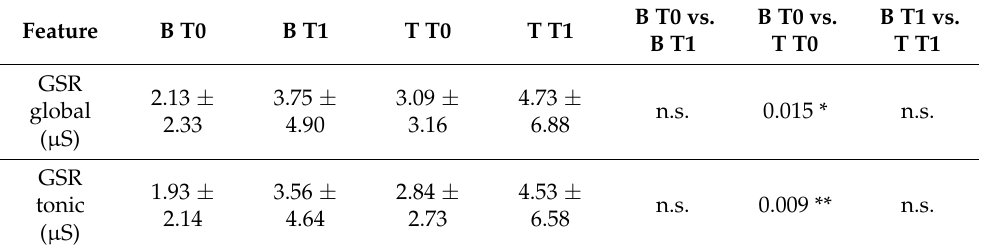
Table 4. Main results concerning the GSR signal analysis (B: baseline, T: task; *: p < 0.05; **: p < 0.01; n.s.: not